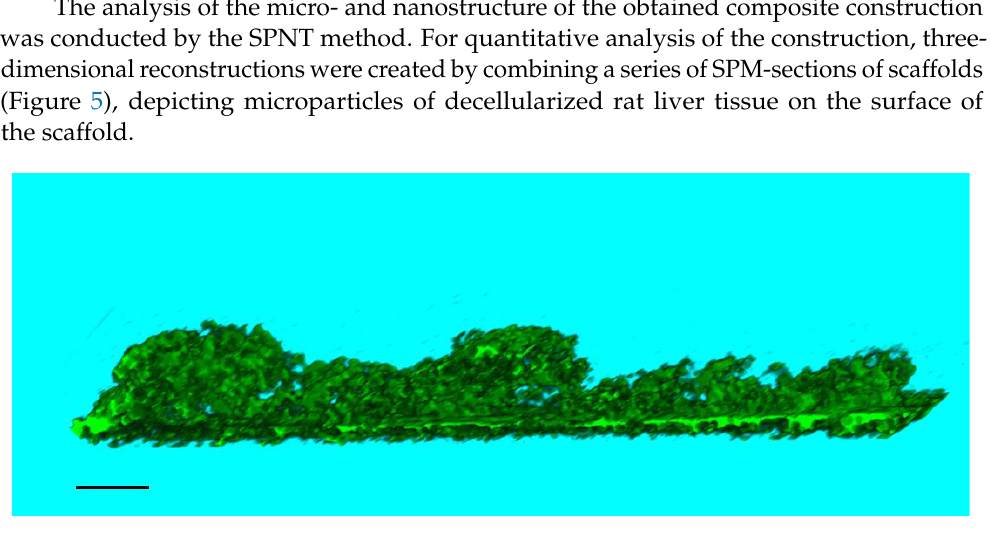
Table 1. Data on the average surface roughness of the obtained scaffolds. Standard deviation val- ues for six independent measurements are shown.